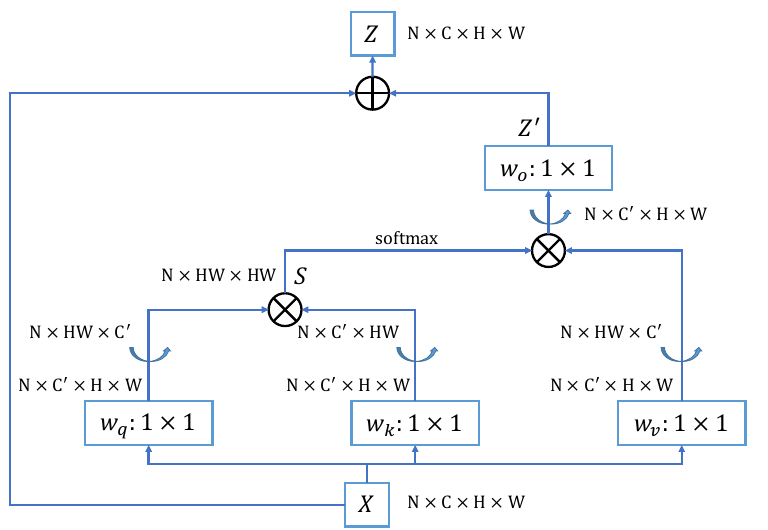
Figure 3. The structure of non-local [34] attention. N , C , H , and W stand for the batch size, channels, height, and weight of the input image X , respectively. w q , w k , w v , and w o stand for the different convolution kernels. S and Z (cid:48) are the middle layers. Z is the output of the non-local